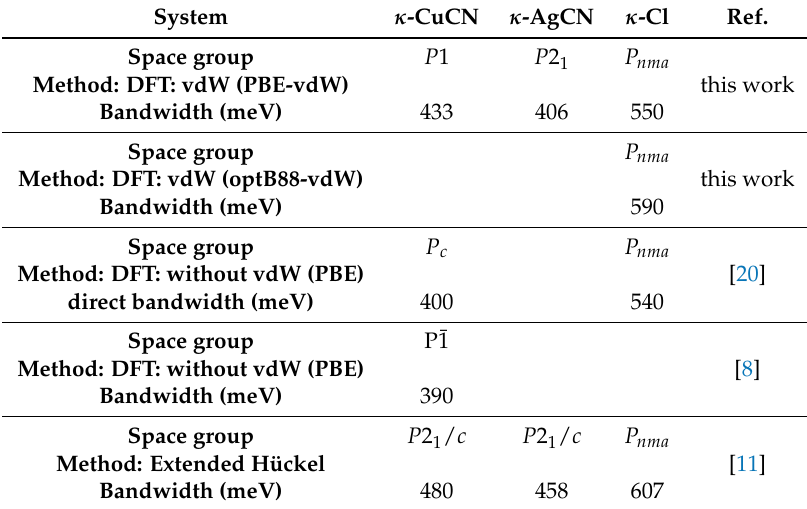
Table 5. Direct bandwidth of κ -CuCN, κ -AgCN, and κ -Cl, defined as the width of antibonding bands straddling the Fermi level at the Γ point obtained from ab initio calculations that include vdW interactions (this work) or without them ([8,11,20]). Space groups are also denoted. System κ -CuCN κ -AgCN κ -Cl Ref. Space group P 1 P 2 1 P nma this work